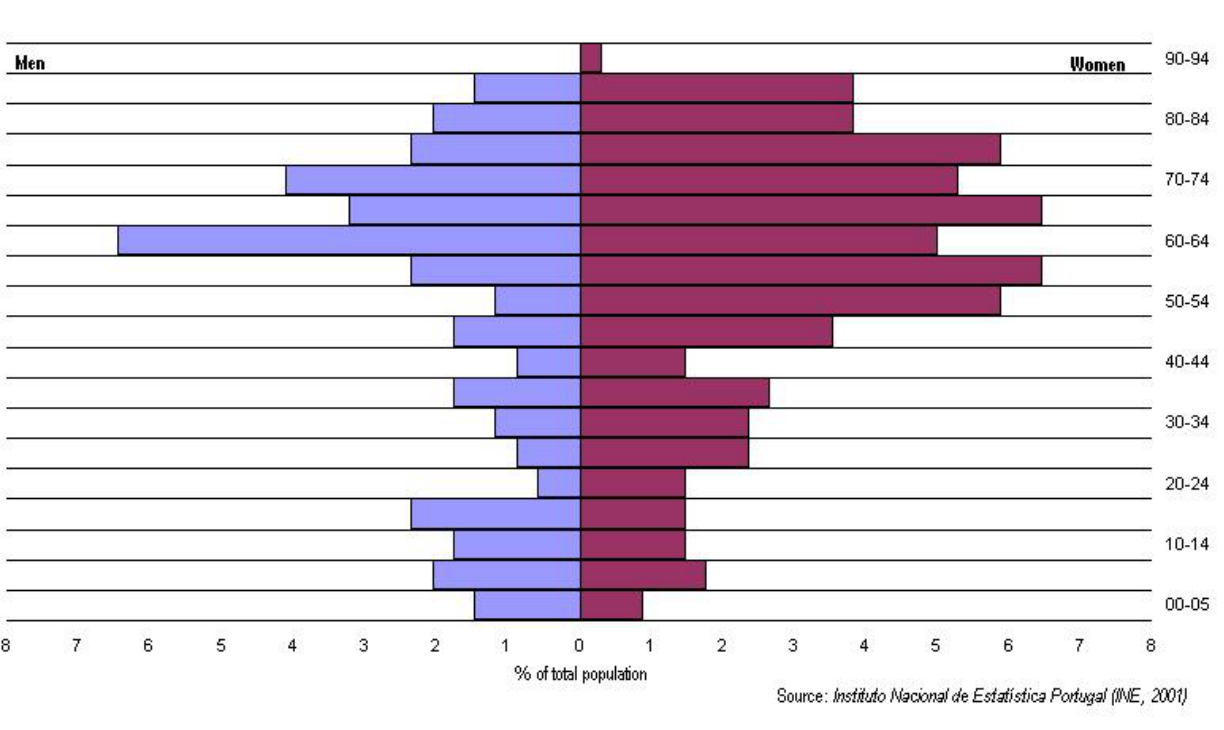
Fig. 4 . Age-structure pyramid of the Sistelo